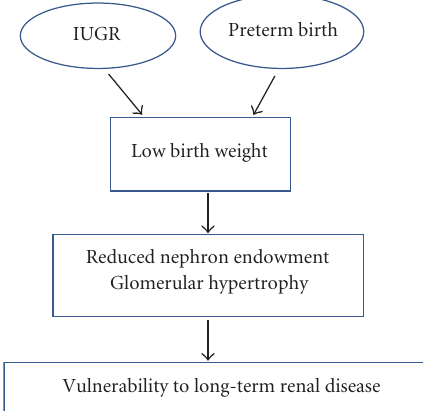
Figure 2: Flow diagram showing the consequences of intrauterine growth restriction (IUGR) and preterm birth which result in low birth weight. Low birth weight may have an adverse e ff ect on nephron endowment and glomerular hypertrophy; together, these may increase the vulnerability of an individual born IUGR or preterm to long-term renal